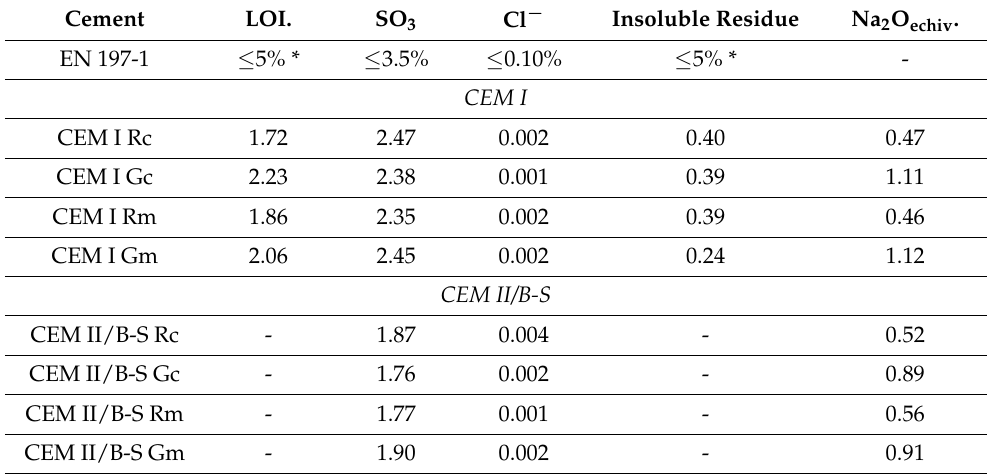
Table 5. The main chemical characteristics assessed for the cements obtained from studied clinkers. Cement